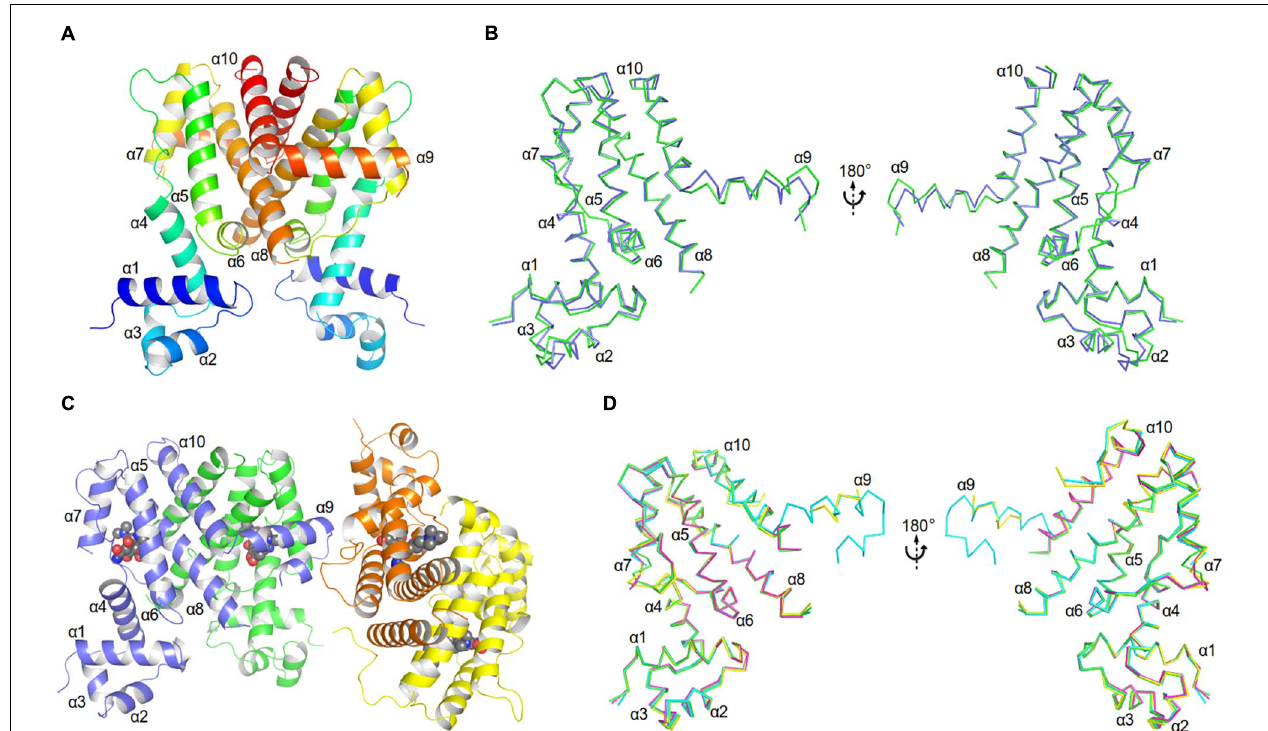
FIGURE 3 | Crystal structures of AbTetR and the minocycline bound AbTetR-Gln116Ala variant. (A) Crystal structure of TetR of A. baumannii AYE (rainbow color, N terminus: blue, C terminus: red). (B) Superimposition of AbTetR-A (green) and AbTetR-B (blue). (C) Binary structure of two dimeric Gln116Ala variants in complex with minocycline. Minocycline molecules are depicted as spheres (carbon: black; oxygen: red; nitrogen: blue). (D) Superimposition of the four monomers of minocycline-bound Gln116Ala (Gln116Ala-A: green, Gln116Ala-B: cyan, Gln116Ala-C: magenta, Gln116Ala-D: yellow).